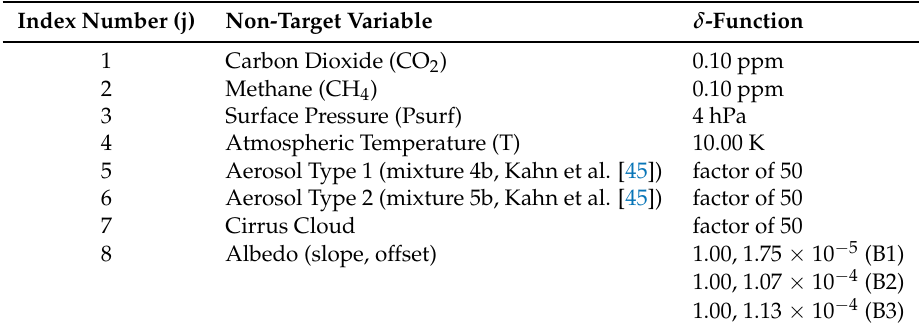
Table 1. List of the non-target state vector variables for which interference uncertainties are calculated. The right-hand column displays the δ -funtion values used in calculating the interference values. B1, B2 and B3 refer to the GOSAT SWIR bands 1–3